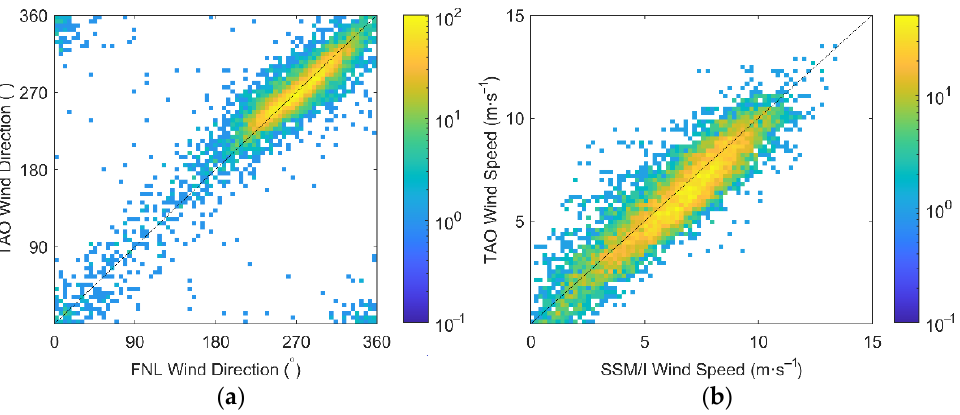
Figure 1. Scatter plots of the TAO paired data. ( a ) Scatter plots of the FNL wind direction. ( b ) Scatter plots of the SSM/I wind speed. The dashed line in this figure is the diagonal line. Table 1. FNL and SSM/I wind field data and TAO sea surface wind velocity data statistical analysis.